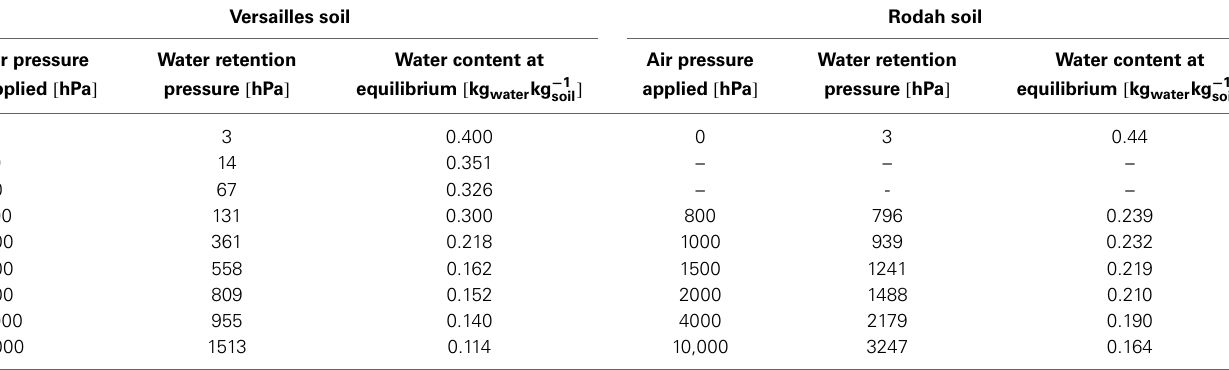
Table 4 | Data of the pressure plate apparatus experiment for the measurement of the water retention curve (pF curve) of two soils.